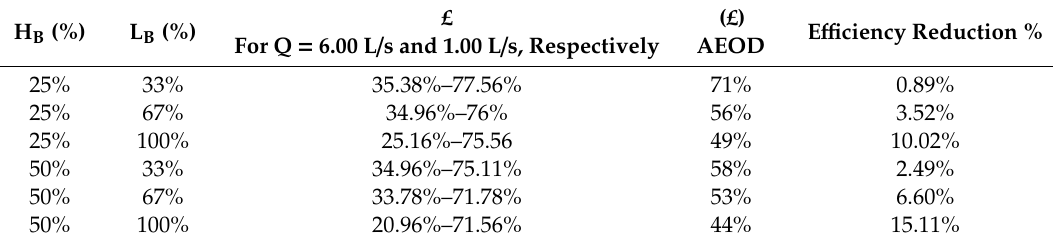
Table 2. The results of e ffi ciency reduction for di ff erent relative blockage lengths and heights.